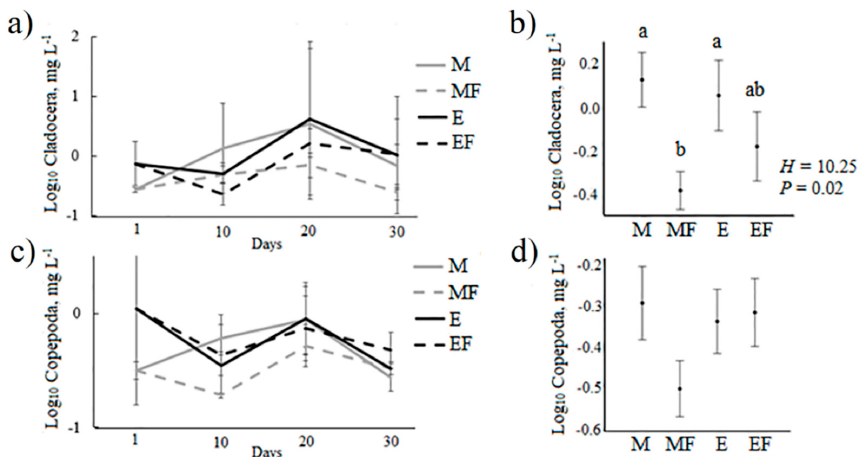
Figure 7. Dynamics of biomass of crustaceans in the experiments ( a , c ) and treatment means ( b , d ); different letters indicate significant differences at P < 0.05 after Kruskal–Wallis test (H); M—mesotrophic conditions, MF—mesotrophic conditions with introduced fish, E—eutrophic conditions, EF—eutrophic conditions with introduced fish.